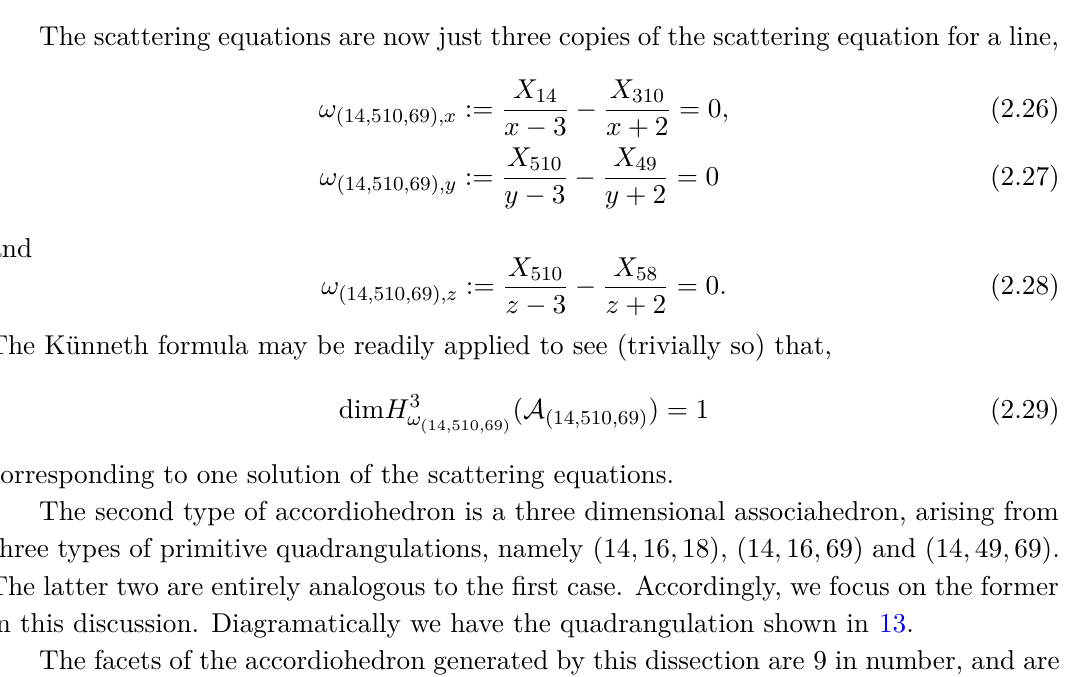
Figure 12 . Accordiohedron for dissection (14 , 510 , 69)